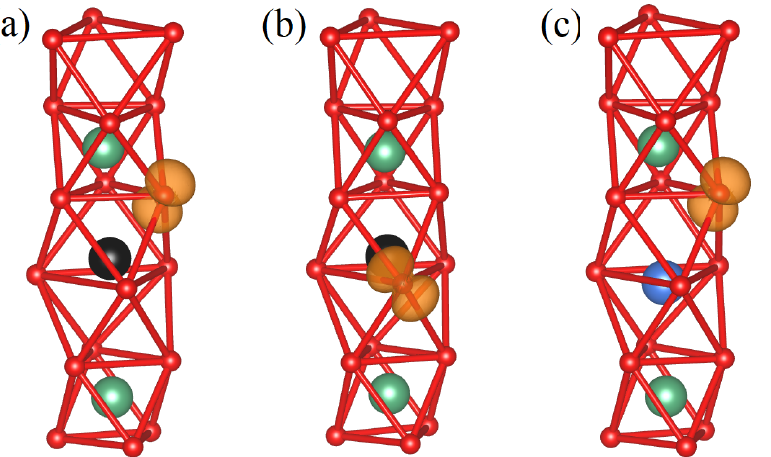
Figure 1. Partial charge densities of the defect(V Li )-bound hole polarons in two possible configura- tions, HP-a ( a ) and HP-b ( b ), as well as self-trapped holes ( c ). Blue, green, and red balls represent lithium, niobium, and oxygen atoms, respectively. Lithium vacancies (i.e., missing Li atoms) are indicated by black balls. The orange clouds show the local depletion of the electronic charge relative to a polaron-free crystal, which is interpreted as the hole